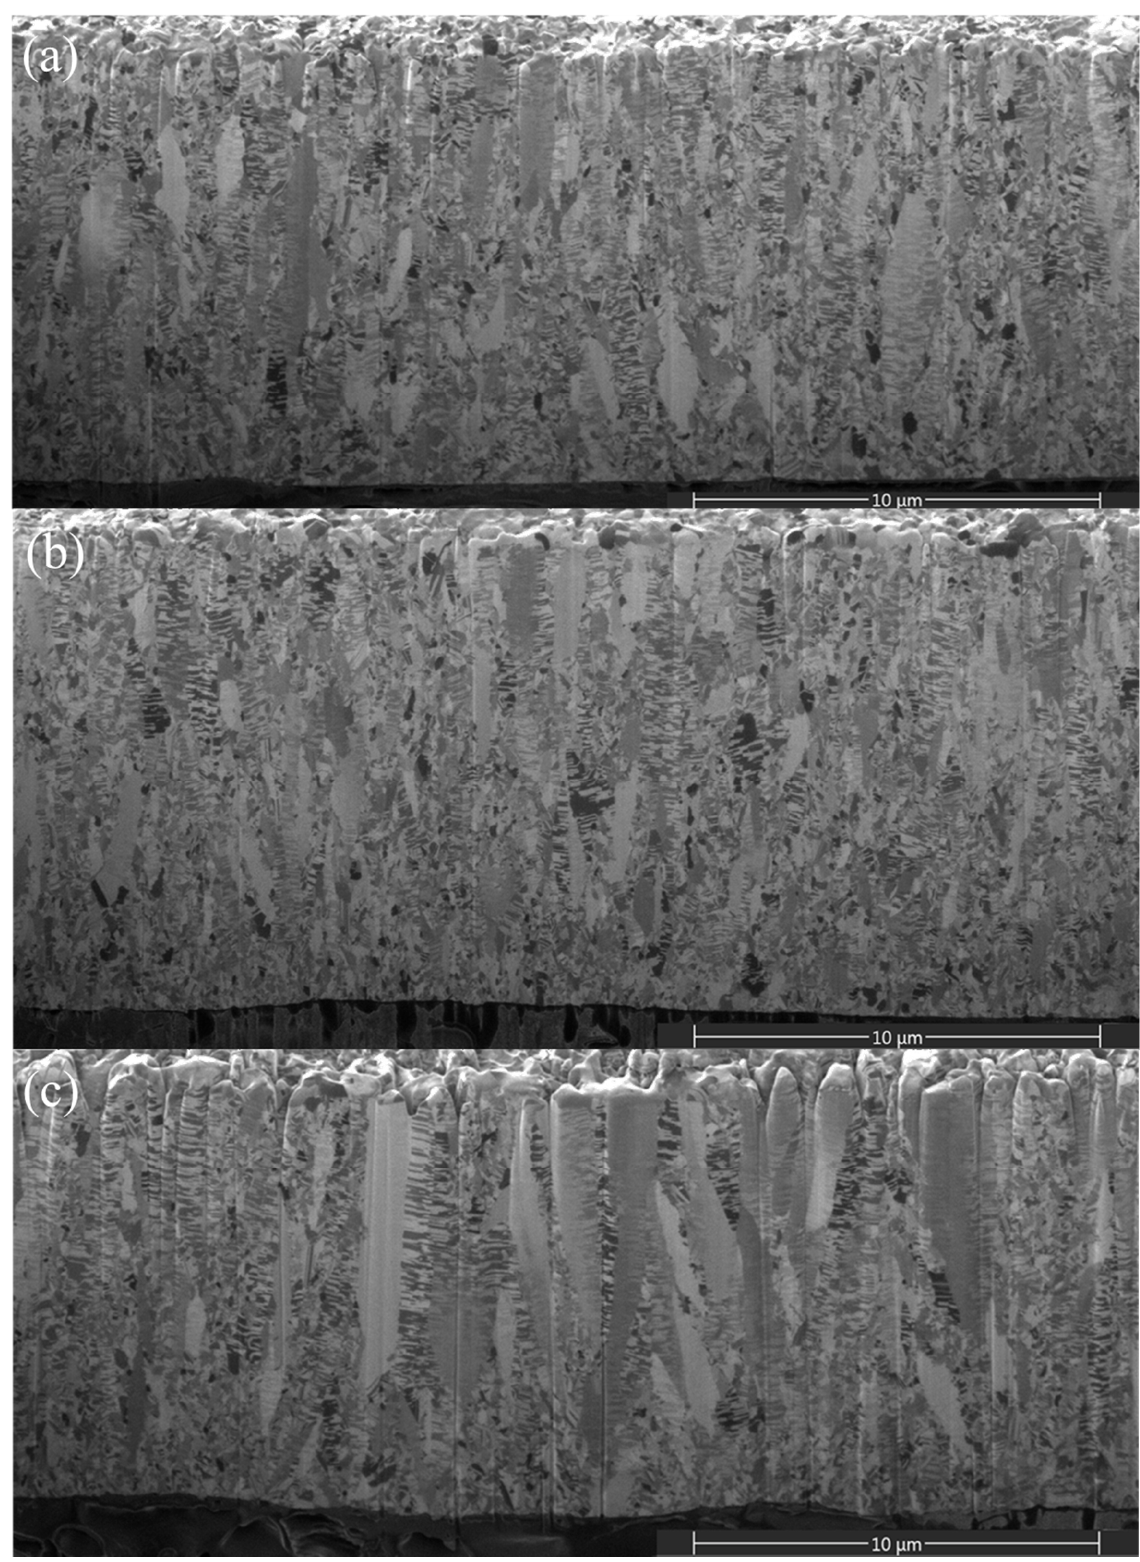
Figure 3. Cross-sectional FIB micrographs of the 15- μ m thick nt-Cu foils electroplated with different concentrations of Cu 2+ : ( a ) 0.3 M; ( b ) 0.5 M; ( c ) 0.8 M.